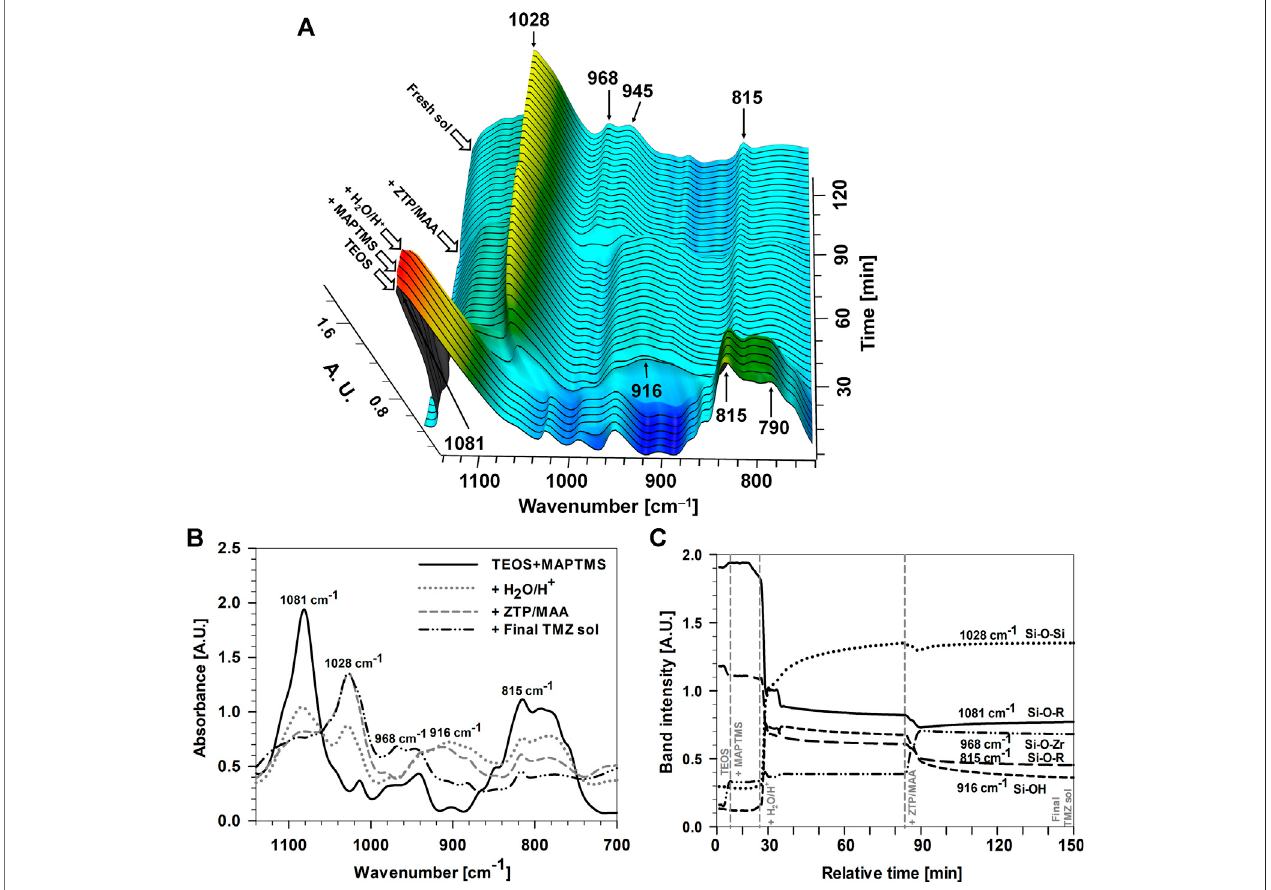
FIGURE3 |(A) 3-DFTIR spectra(increment3 min) (B) individual FTIR spectra and (C) band intensity recorded during the addition ofH 2 O/H + toTEOS +MAPTMS (Sol 1) as a function of reaction time. Arrows in Figure 2A and dashed horizontal lines in Figure 2C marked the points when MAPTMS, H 2 O/H + and ZTP/MAA (Sol 2) were added to the initial TEOS to obtain the fi nal TMZ